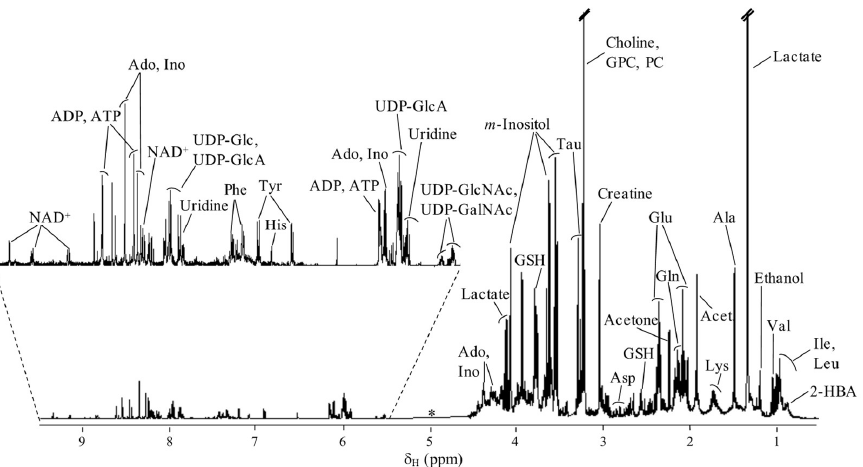
93 93 by the 94 100 101 102 102